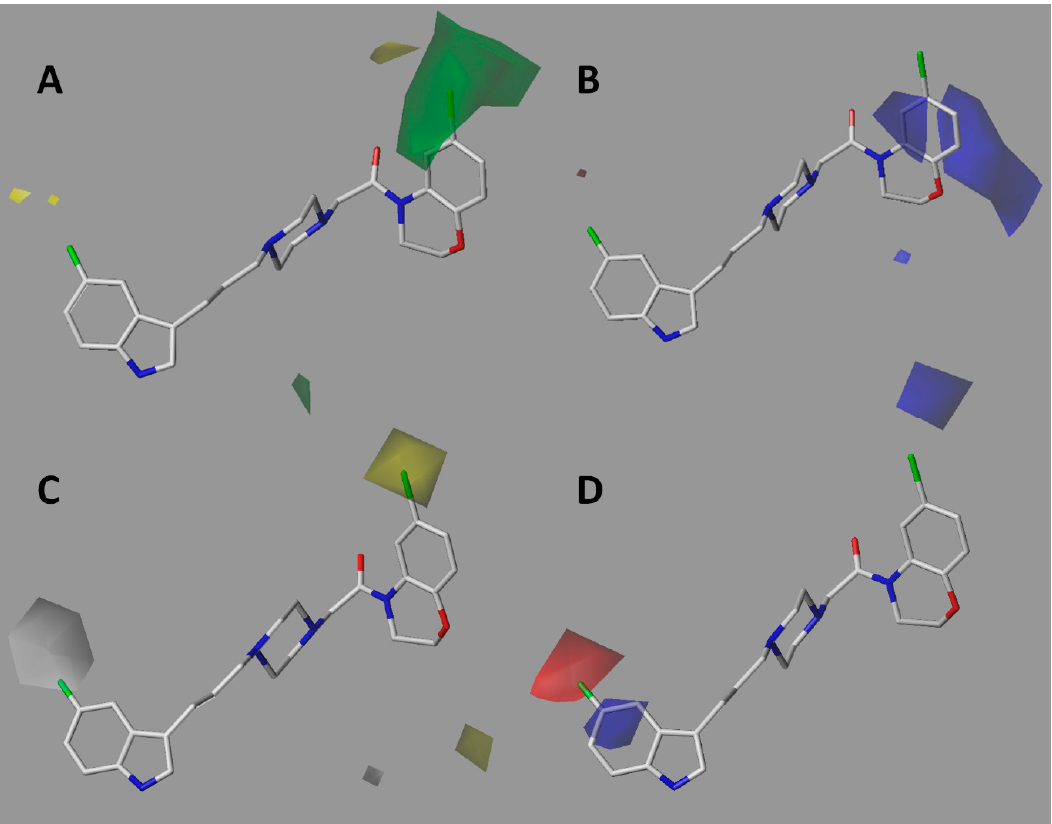
Figure 5. CoMFA ( A , B ) and CoMSIA ( C , D ) contour maps for the entire series of compounds evaluated in SERT. The compound with the best SERT affinity ( 7k ) is depicted. A. Steric contour map. Green means that large groups are favorable for activity. B and D. Electrostatic contour maps. Red means electron-rich atoms are favorable and blue means positively charged atoms are favorable. C. Hydrophobic map. Gray means that hydrophilic groups are favorable for activity and yellow means that hydrophobic groups are favorable.